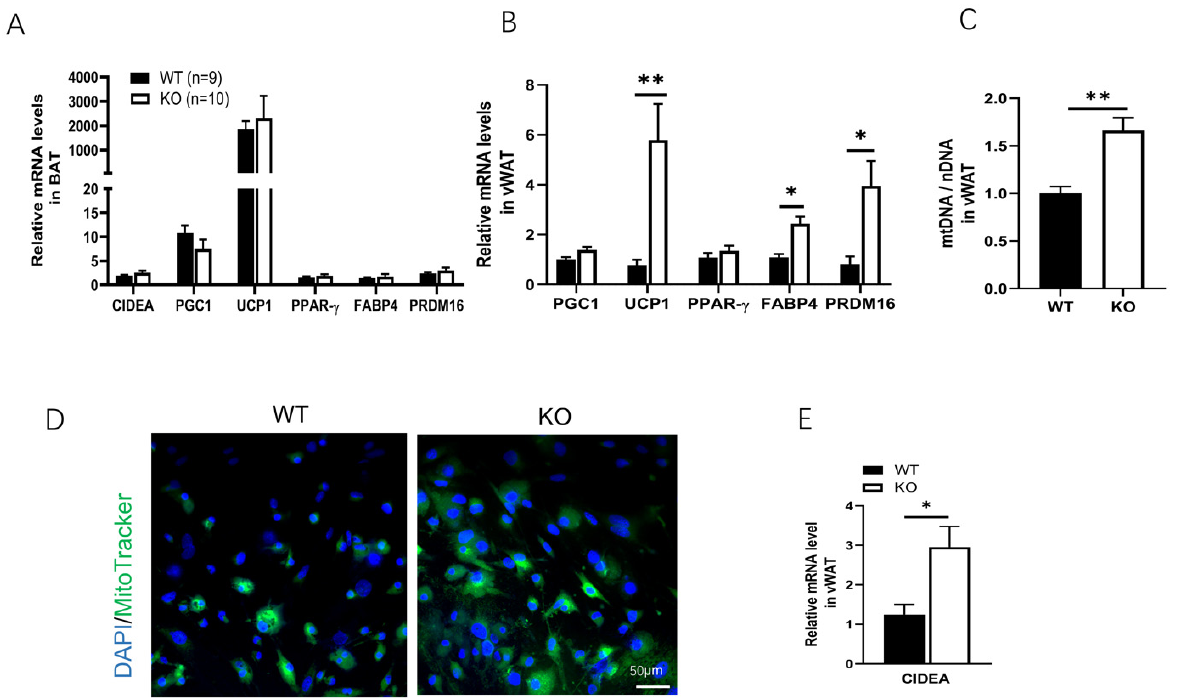
Figure 2. WAT from SPL KO mice showed higher browning-related gene expression and in- creased mt DNA level. ( A ) Expression of CIDEA, PGC-1a, UCP1, PPAR- γ , FABP4, and PRFM16 relative to beta-actin in brown adipose tissue (BAT) and vWAT ( B ). ( C ) Relative mitochondria DNA (mtDNA/nDNA) levels in vWAT from WT and KO mice. ( D ) Mitochondria tracker staining of mitochondria in vWAT from WT and KO mice. Green: mitochondria, blue: nuclei. ( E ) Relative expression of CIDEA mRNA in vWAT from WT and KO mice. 10 weeks old animal experiments were performed with n = 9–10 mice in each group. Unpaired Student’s t -test was performed to compare the difference between WT and KO. * p < 0.05, ** p < 0.01. All data are presented as means ± SEM.